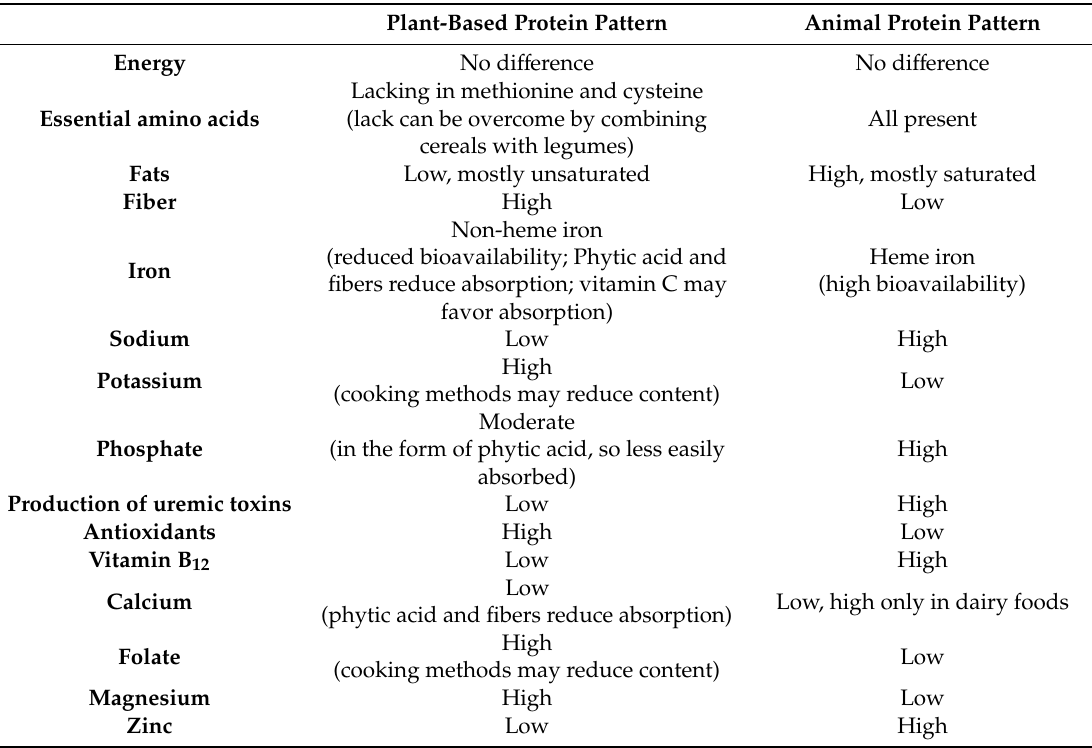
Table 2. Main di ff erences between the nutritional profiles of plant- and animal-derived protein patterns. Plant-Based Protein Pattern Animal Protein Pattern Energy No di ff erence No di ff erence Lacking in methionine and cysteine Essential amino acids (lack can be overcome by combining All present cereals with legumes) Fats Low, mostly unsaturated High, mostly saturated Fiber High Low Non-heme iron Heme iron (reduced bioavailability; Phytic acid and Iron (high bioavailability) fibers reduce absorption; vitamin C may favor absorption) Sodium Low High High Potassium Low (cooking methods may reduce content) Moderate Phosphate (in the form of phytic acid, so less easily High absorbed) Production of uremic toxins Low High Antioxidants High Low Vitamin B 12 Low High Low Calcium Low, high only in dairy foods (phytic acid and fibers reduce absorption) High Folate Low (cooking methods may reduce content) Magnesium High Low Zinc Low